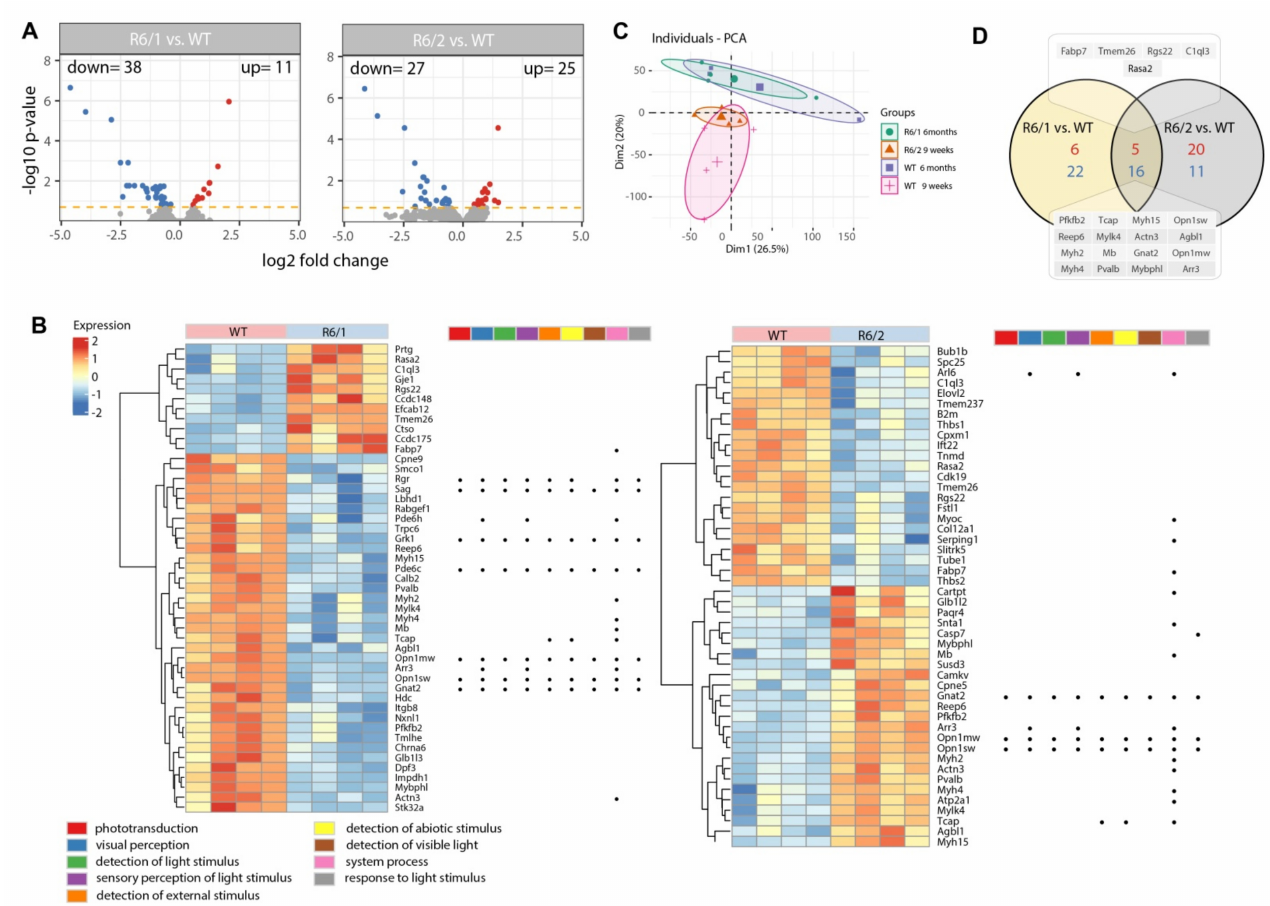
Figure 1. Transcriptome profiling in the eyes of symptomatic Huntington’s Disease (HD) mouse models. Nine weeks old R6/2 mice and 6 months old R6/1 mice were analyzed. ( A ) Volcano plots where each dot represents the average normalized expression of a single gene. Orange dashed lines represent cut-off values ( p < 0.05 with 20% false discovery rate correction). Blue dots are down-regulated genes, while red dots are up-regulated. ( B ) Heatmap with hierarchic clustering of differentially expressed genes. Genes belonging to the significantly enriched ontological group with the strongest effects (lowest adjusted p -value) are shown as dots. ( C ) Principal component analysis (PCA) plots showing the first two principal components of the filtered microarray data set. ( D ) Venn diagram displaying different and common DEGs regulated in the R6/1 vs. WT 6 months old mice and R6/2 vs. WT 9 weeks old mice. Symbols of common genes are